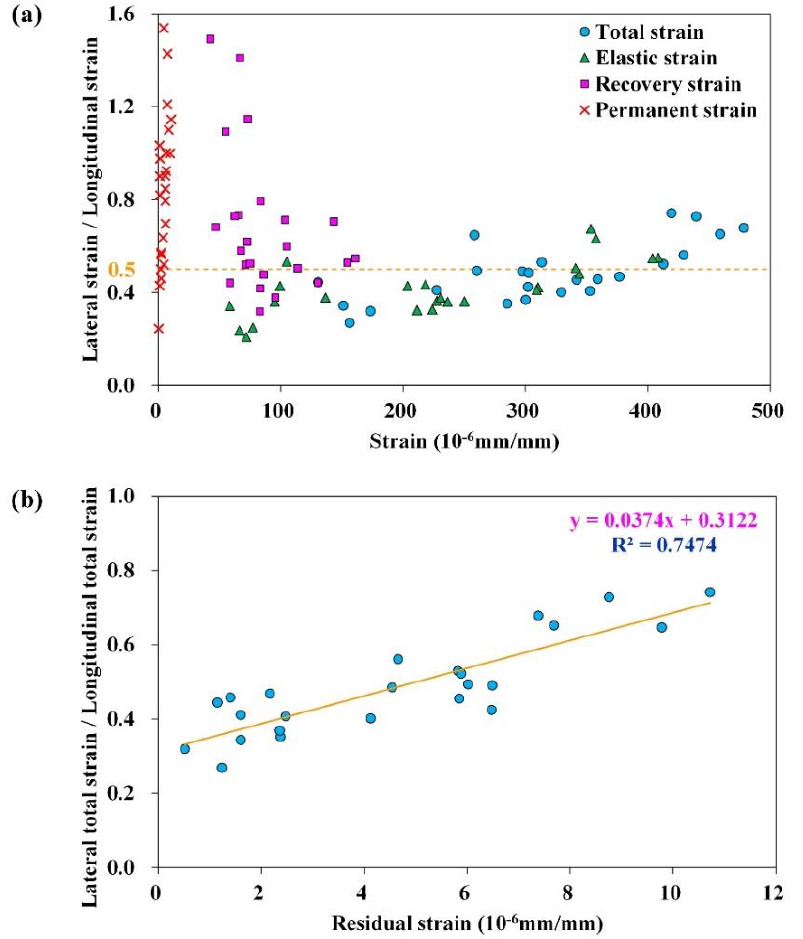
Figure 11. The ( a ) RLSLS value distribution of different strain types and ( b ) the linear fitting of ν total . and vp total and ε vp